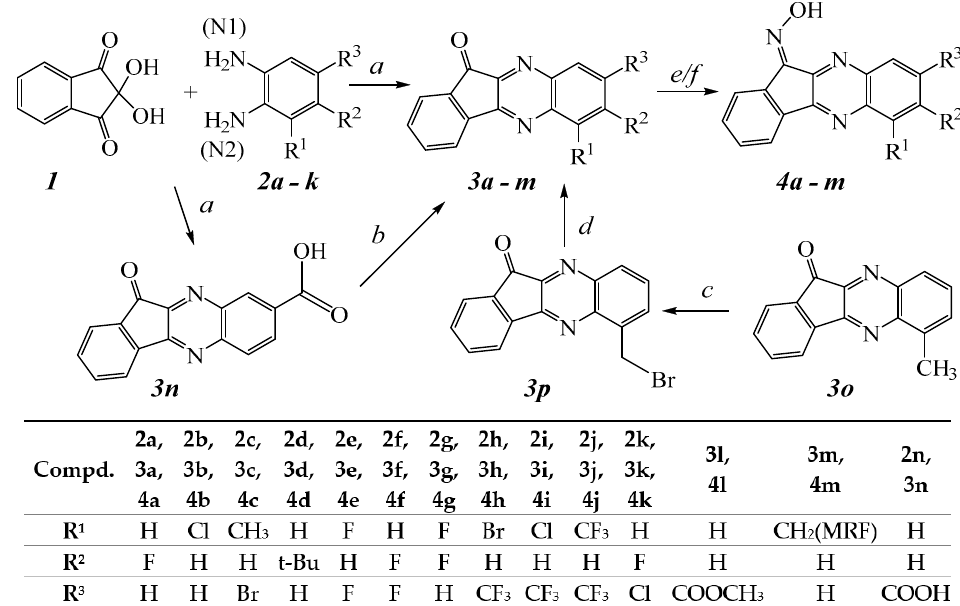
Table 2. Mulliken charges on nitrogen atoms of 2a–k , 2n